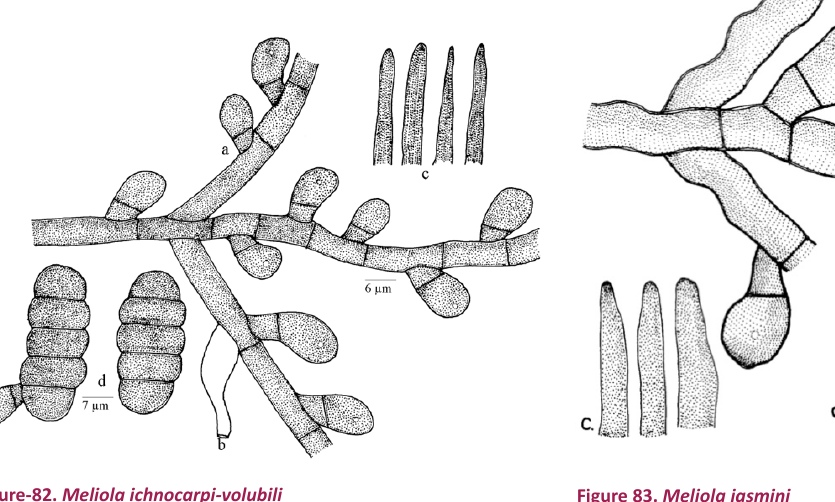
Figure 83. Meliola jasmini a - Appressorium; b - Phialide; c - Apical portion of mycelial setae; d -